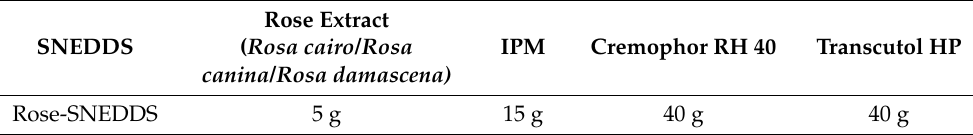
Table 6. Compositions of the formulated SNEDDS containing different rose extracts. Rose Extract SNEDDS ( Rosa cairo/Rosa IPM Cremophor RH 40 Transcutol HP canina/Rosa damascena) Rose-SNEDDS 5 g 15 g 40 g 40